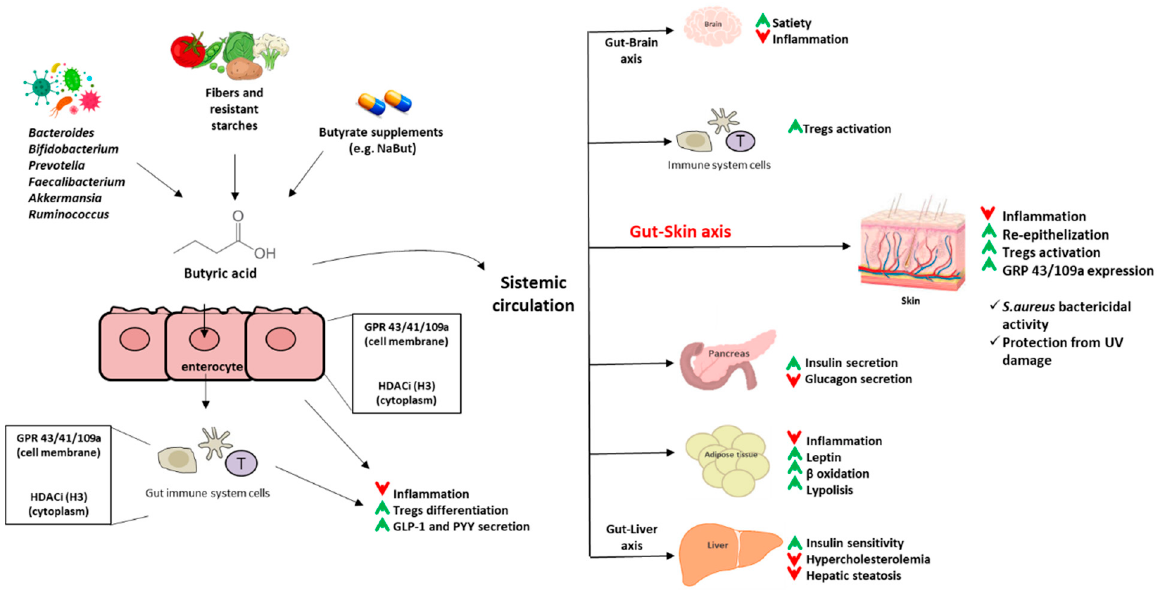
Figure 3. Schematic illustration of the main effects of butyrate on the regulation of host functions. Butyrate positive effects are indicated with a green arrow, negative ones are indicated with red arrows. Abbreviations: NaBut: sodium butyrate; GPR: G-protein coupled receptor; HDACi: histone deacetylase inhibitor; Tregs: T regulatory cells; GLP-1: Glucagon-like peptide 1; PYY: Peptide YY.